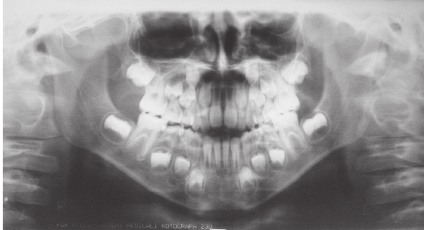
Figure 2: Panoramic radiograph. Normal TMJ structures, without